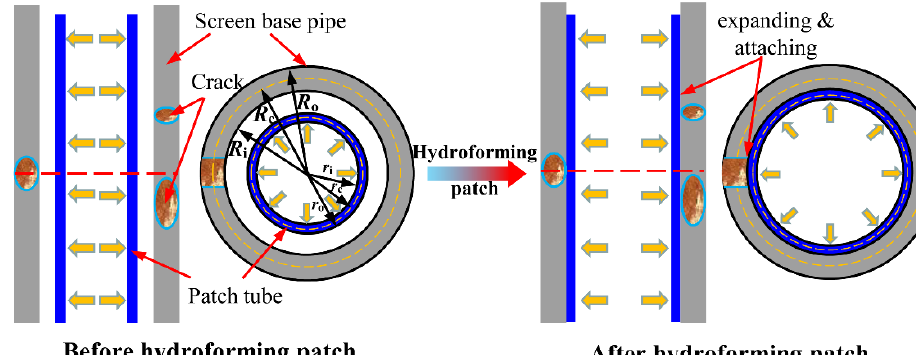
Figure 2. Hydroforming patch technology.